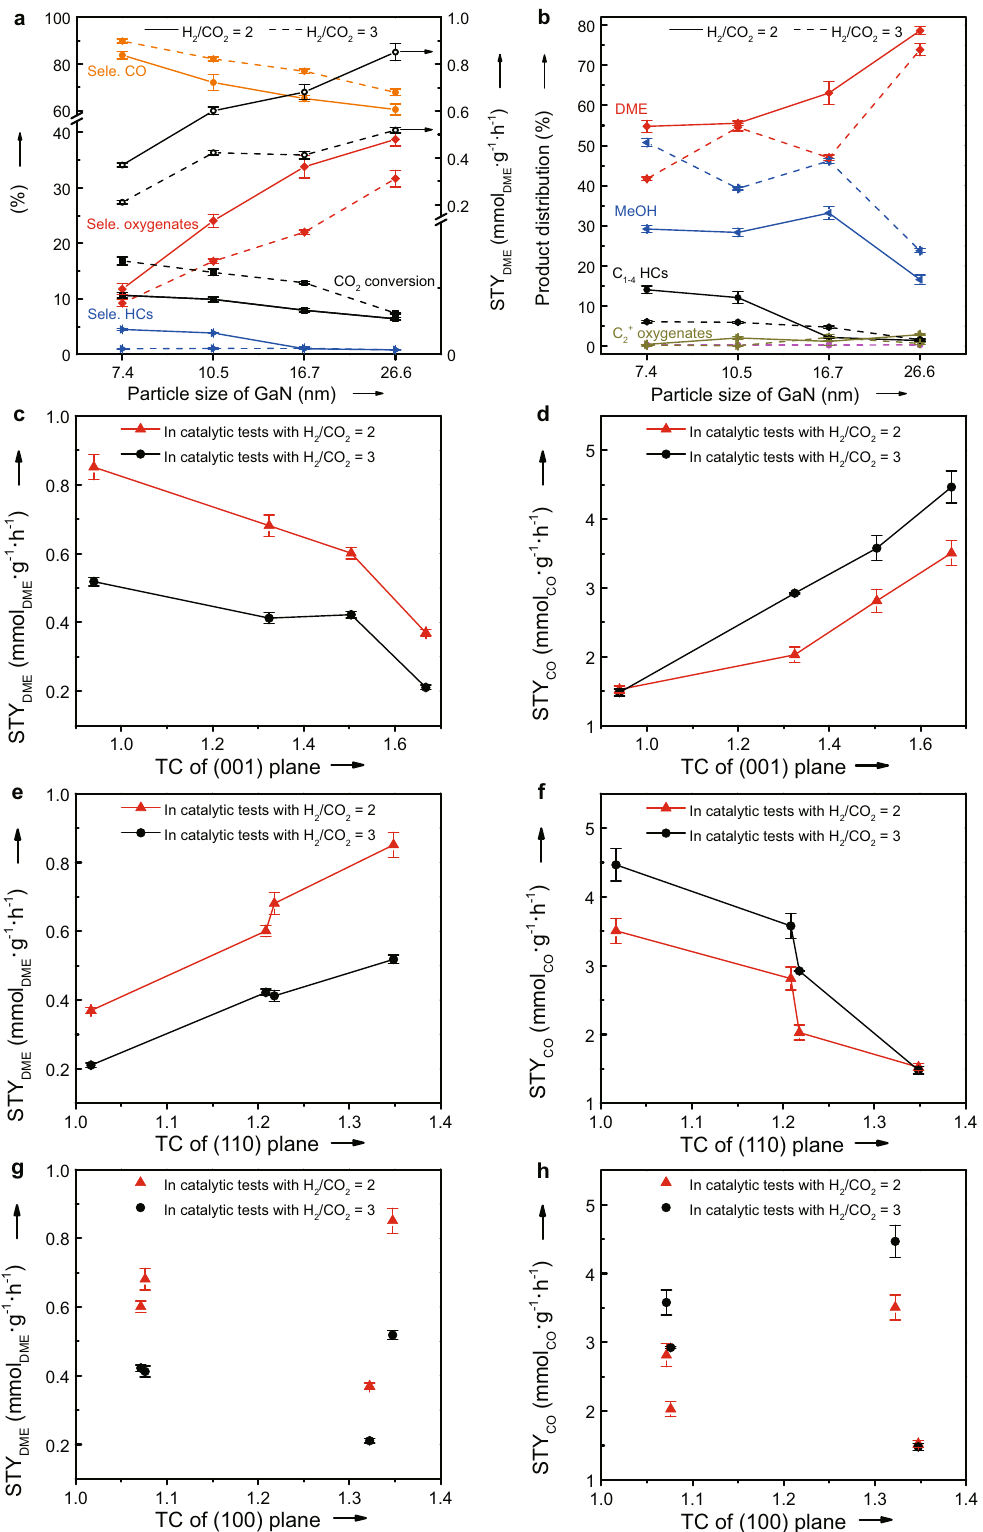
Fig. 3 Effect of GaN crystal properties on the catalytic performance. a Size effect on the CO 2 conversion, selectivity (Sele.) of different products and the space-time yield of DME (STY DME ). b The CO-free distribution of hydrocarbons (HCs) and oxygenates for the hydrogenation of CO 2 ; c – h The correlation between the textural coef fi cients (TC) of (001), (110), and (100) planes with STY DME and the space-time yield of CO (STY CO ). Reaction conditions: P = 2.0 MPa, T = 360 °C, H 2 /CO 2 = 2 or 3, gas hourly space velocity = 3000 mL g − 1 h − 1 , and time on stream = 40 h. The error bar representing the relative deviation is within